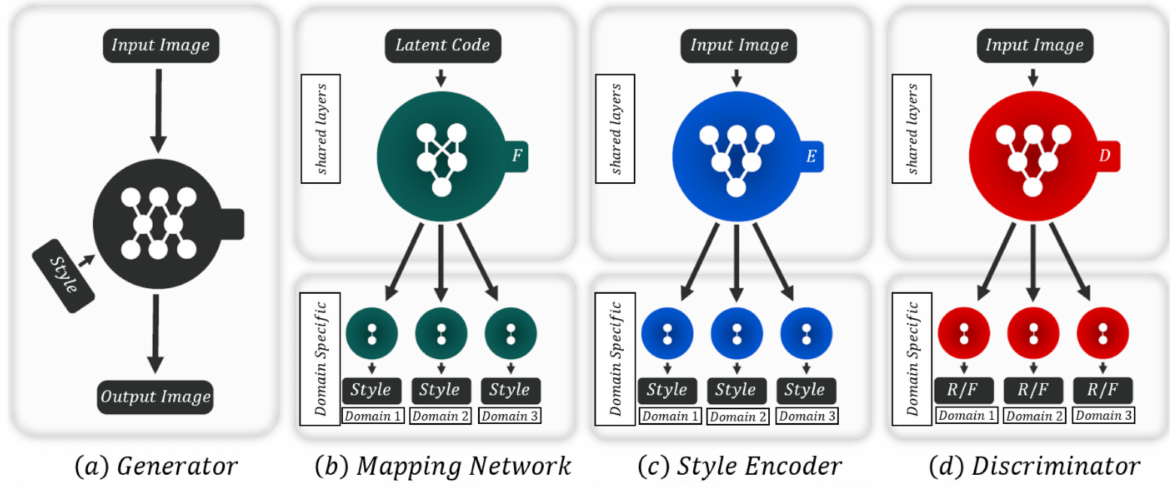
Figure 12. StarGANv2 with four neural networks